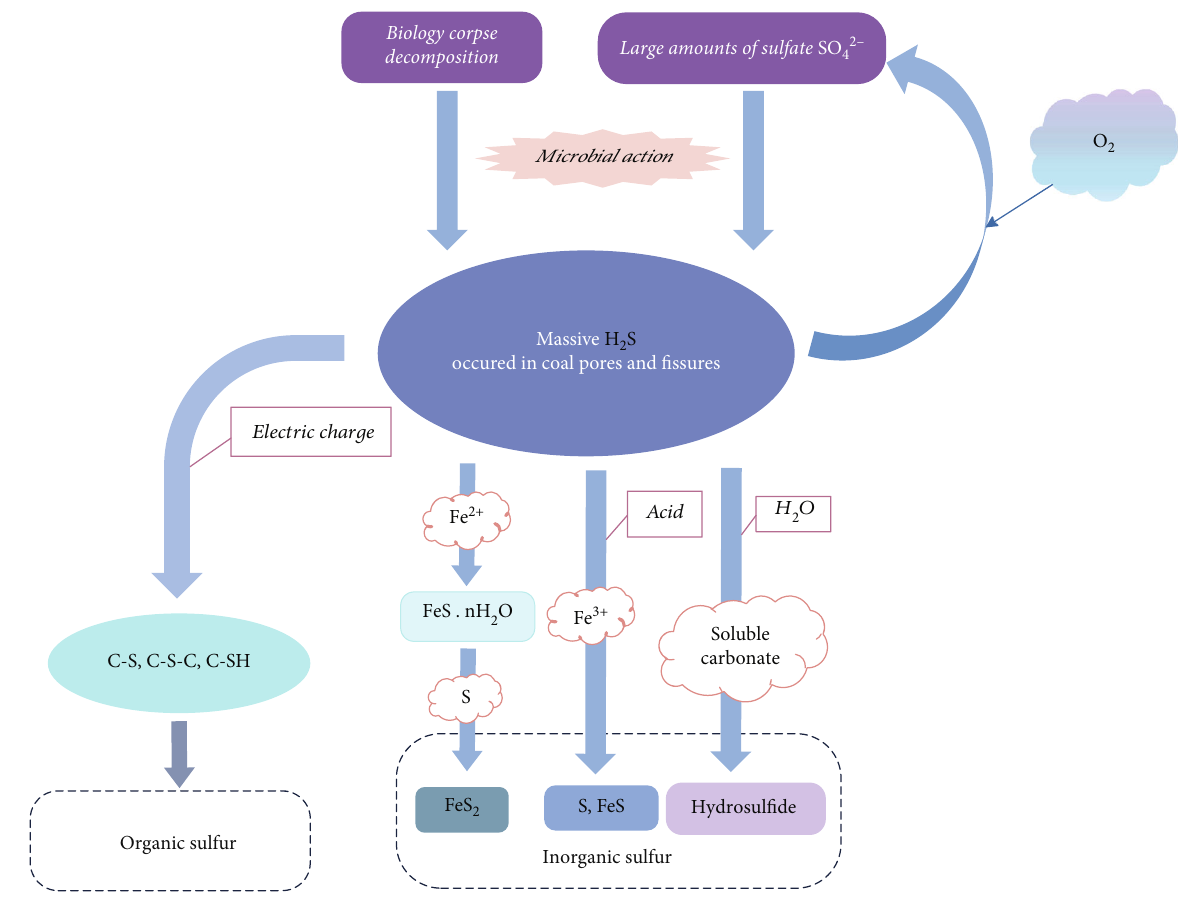
Figure 11: Occurrence relationship between sulfur and H